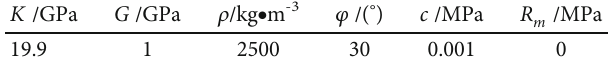
Figure 3: Stress-strain relationship of rock mass in caving zone and mechanical inversion of double-yield model. Table 2: Mechanical parameters of rock mass fi lled in caving